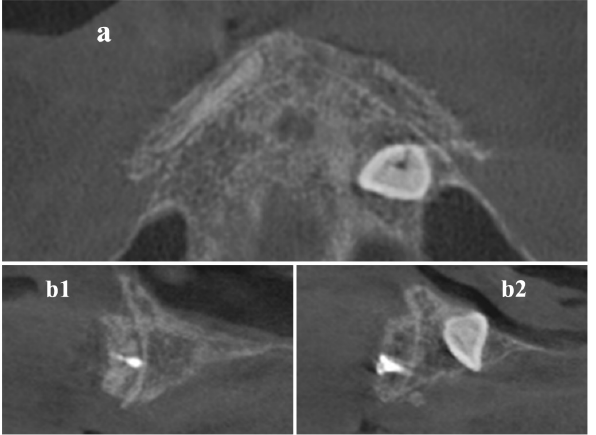
Figure 4. The custom-made freeze-dried bone allograft (FDBA) was positioned in the deficit area and stabilized with a screw. (a) Anatomical site prior surgical procedure and clinical view of the defect. (b1,b2) Screw positioning on a custom-made FDBA. (c) Sutures. Preceding to the second phase, supplementary CBCT scans were performed to evaluate grafts gain (Figure 5).